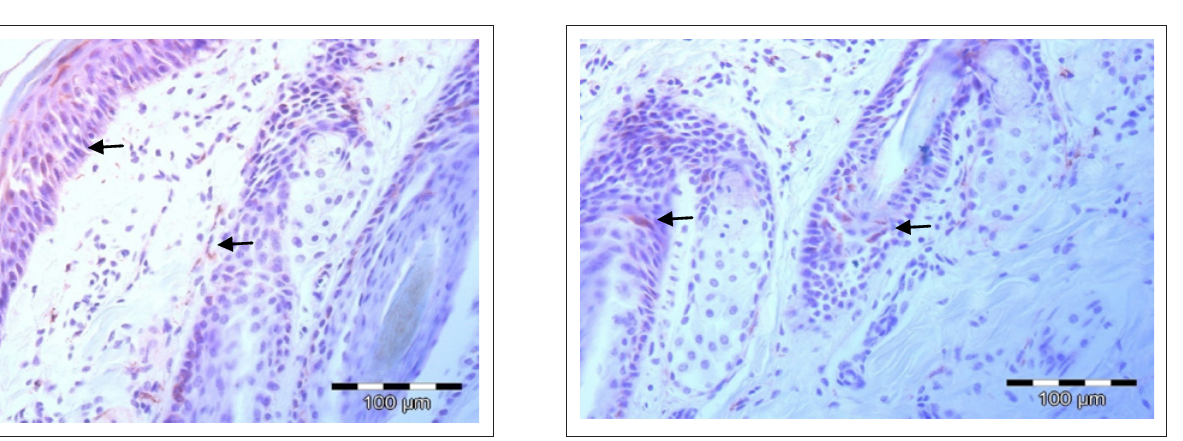
FIGURE 4: Positive NovaRED staining in the epidermis (top arrow) and hair follicle epithelium (bottom arrow) of a persistently infected calf (Magnification: 40x).